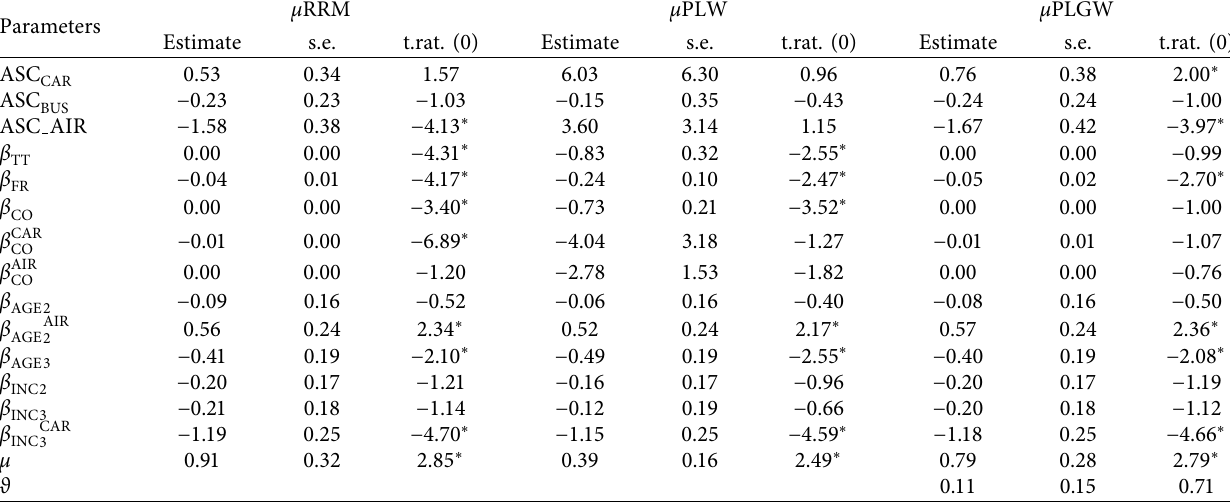
Table 13: Estimates of the μ RRM, μ PLW, and μ PLGW for nonbusiness purpose of the HSR experiment.